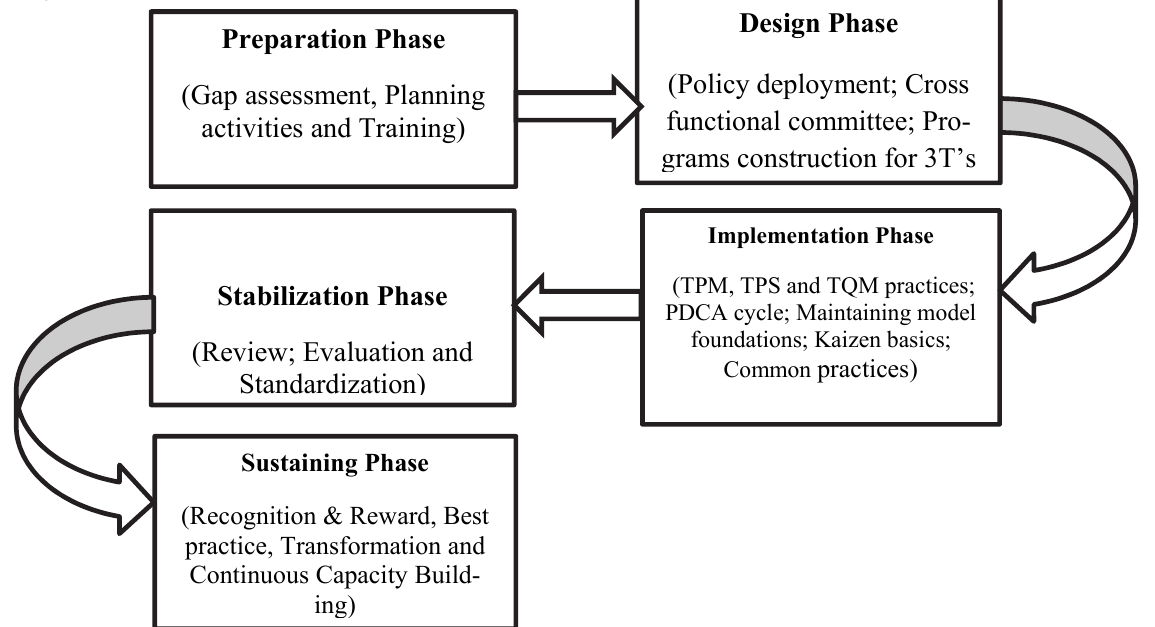
Fig. 3. Developed Implementation Guide